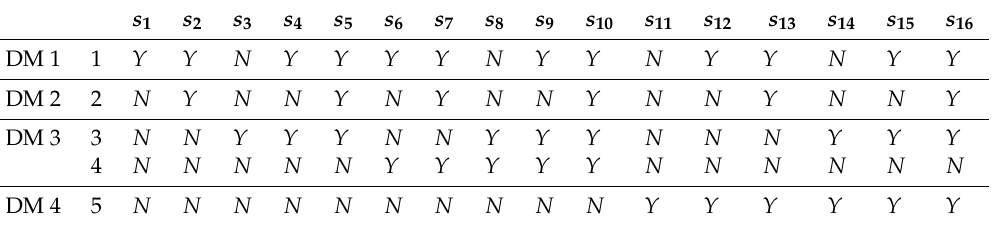
Figure 9 indicates the irreversible moves of this conflict in “GMCR +”, where double-sided arrows represent reversible moves from one option to another, while the one-way arrows show the only direction of moves. For example, DM 3 can only move from not choosing O 3 to choosing it, but not vice versa.